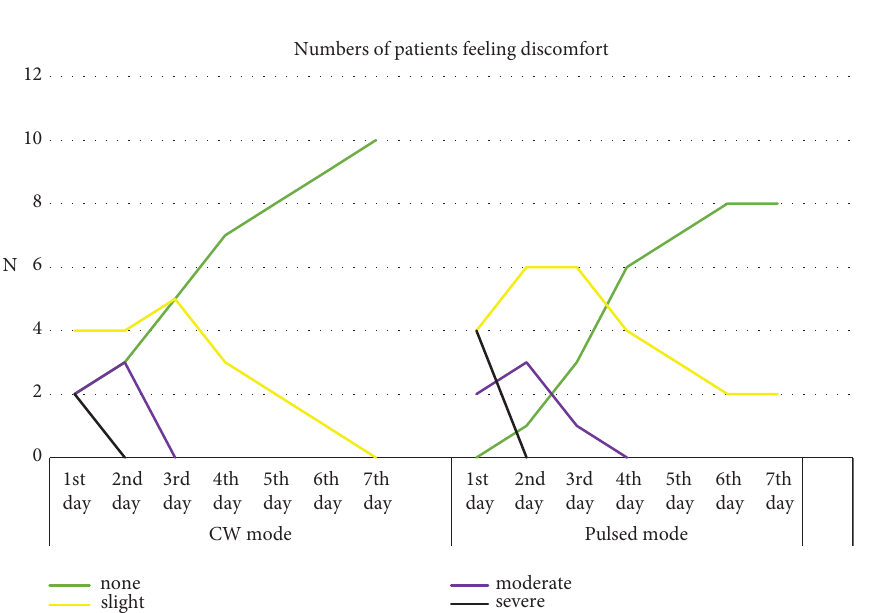
Figure 2: Reveals a decreased number of patients feeling discomfort during the frst week of treatment with either CW or pulsed diode laser